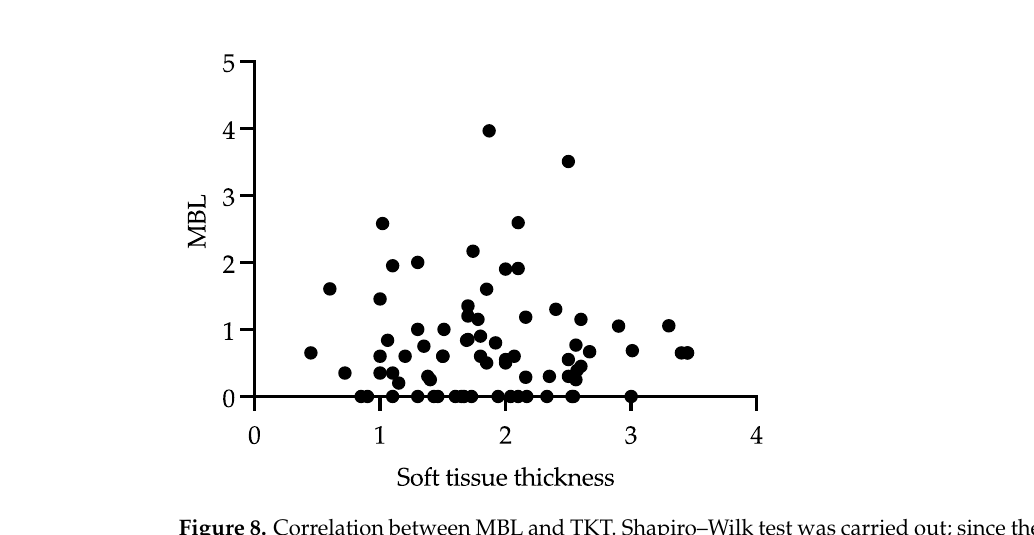
Figure 8. Correlation between MBL and TKT. Shapiro–Wilk test was carried out; since the distribution was not normal, the Spearman’s r correlation was used. r = 0.02662.